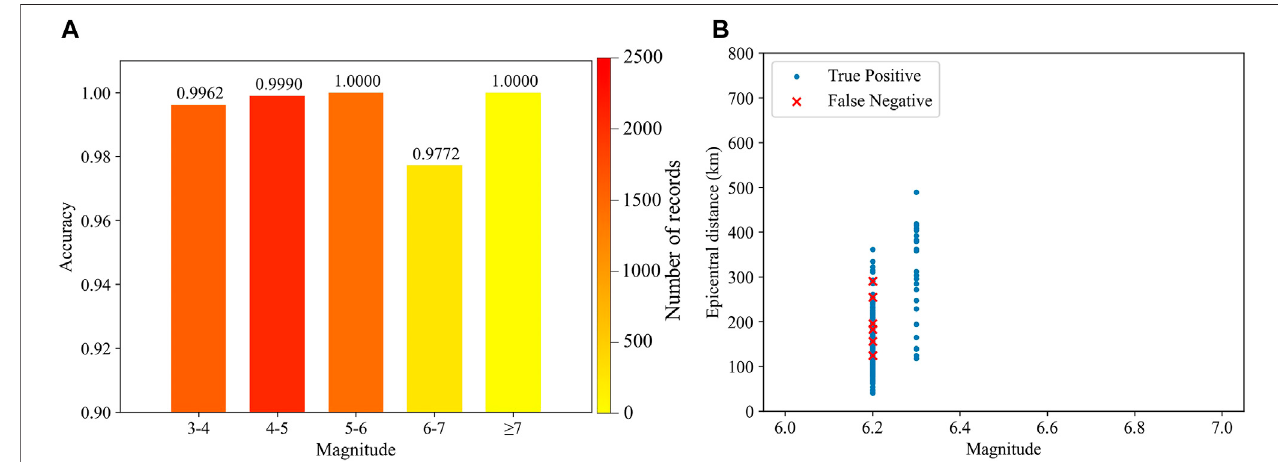
FIGURE 8 | (A) Dependence of the performance on earthquake magnitudes. The colors of the columns are the number of test waveforms in the bins. (B) The relationshipbetweentheepicenterdistancesandmagnitudesofearthquakeswith6 ≤ M < 7forthetestingset.Thebluepointsarethetruepositives,andtheredcrosses are the false negatives.